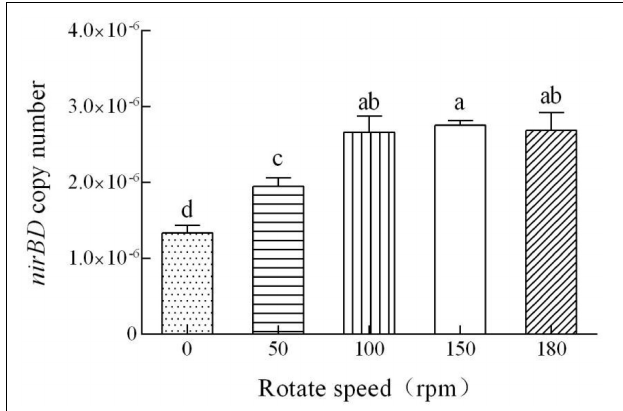
FIGURE 8 | Quantitative measurement of the nirBD expression in Pseudomonas putida Y-9 cultured at different shaking speeds (with glucose as the sole carbon source) for 4 d. The values are expressed as the number of copies/10 10 copies of 16S rRNA. The different lowercase letters above the bars indicate significant differences among treatments ( P <